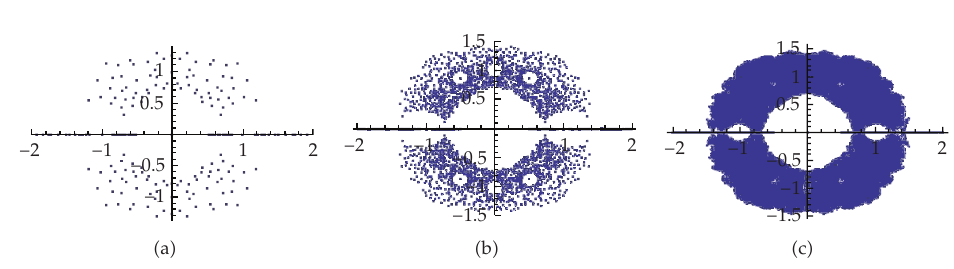
Figure 1: The position, on the complex plane, of the zeros of 50000 random integer polynomials with coe ffi cients − 1, 0, or 1, for degrees up to 4 in part (cid:5) a (cid:6) , 6 in part (cid:5) b (cid:6) , and 10 in part (cid:5) c (cid:6)